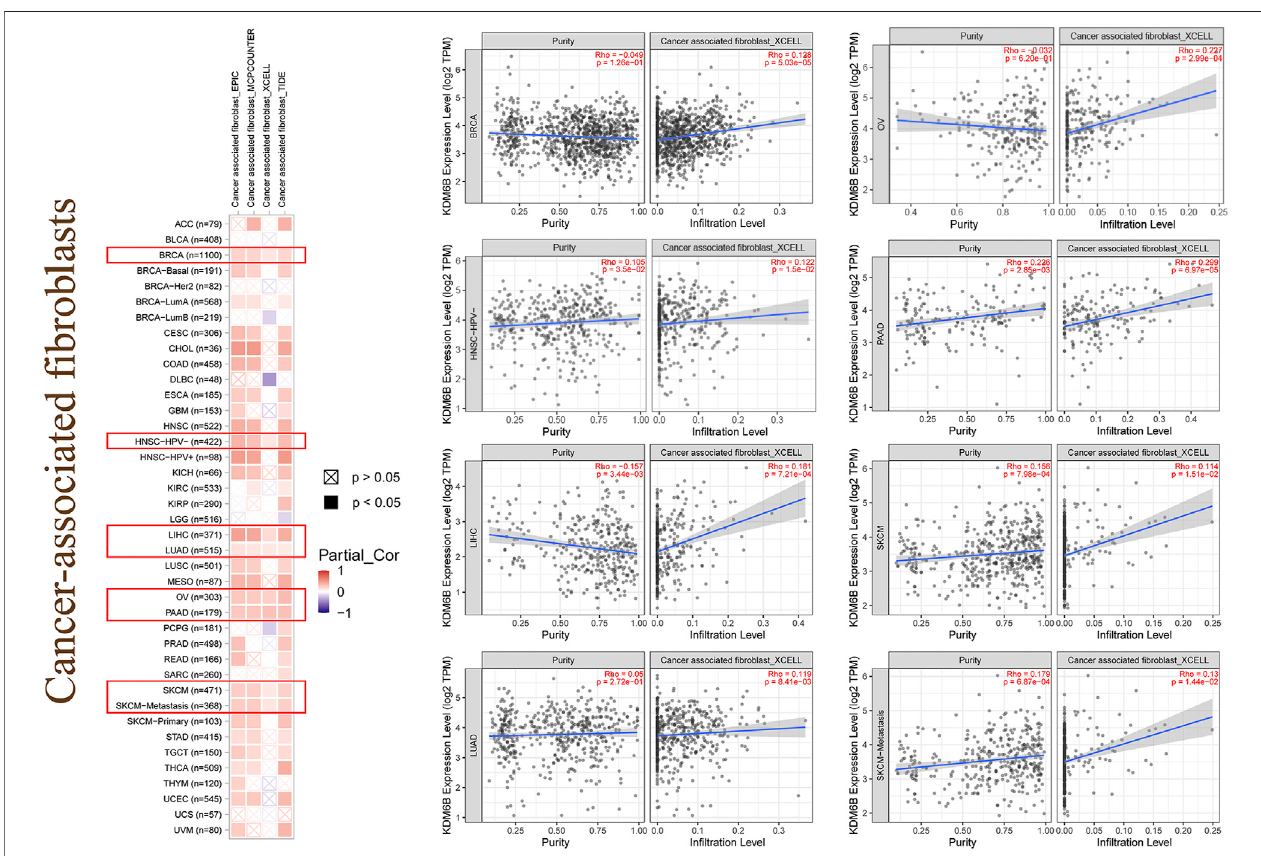
FIGURE5 | Immune in fi ltration ofcancer-associated fi broblasts. Different algorithms wereused toexplore the potential correlation between theexpression level of the KDM6B and the in fi ltration level of cancer-associated fi broblasts across all types of cancers in TCGA.